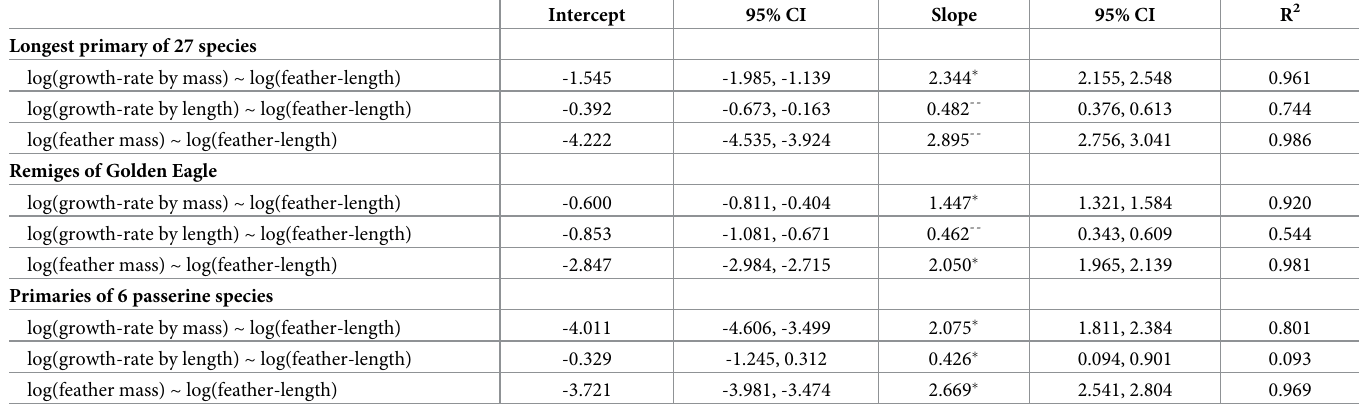
Table 3. Reduced major axis regressions between feather growth-rate by mass and feather-length, between feather growth-rate by length and feather-length, as well as between feather mass and feather-length.